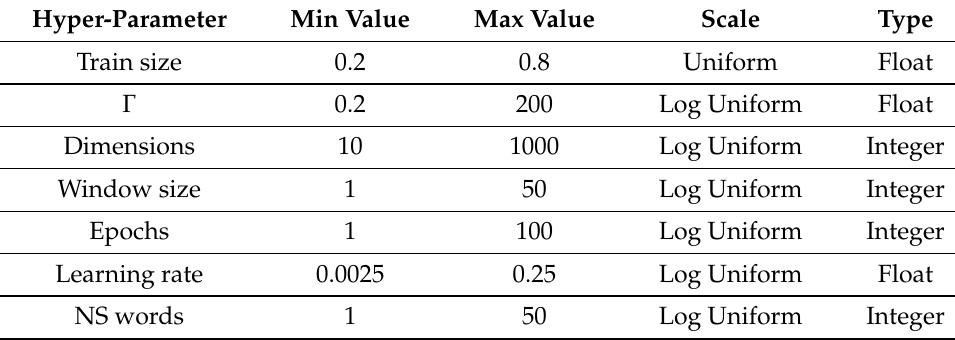
Table 5. Random search characteristics of each